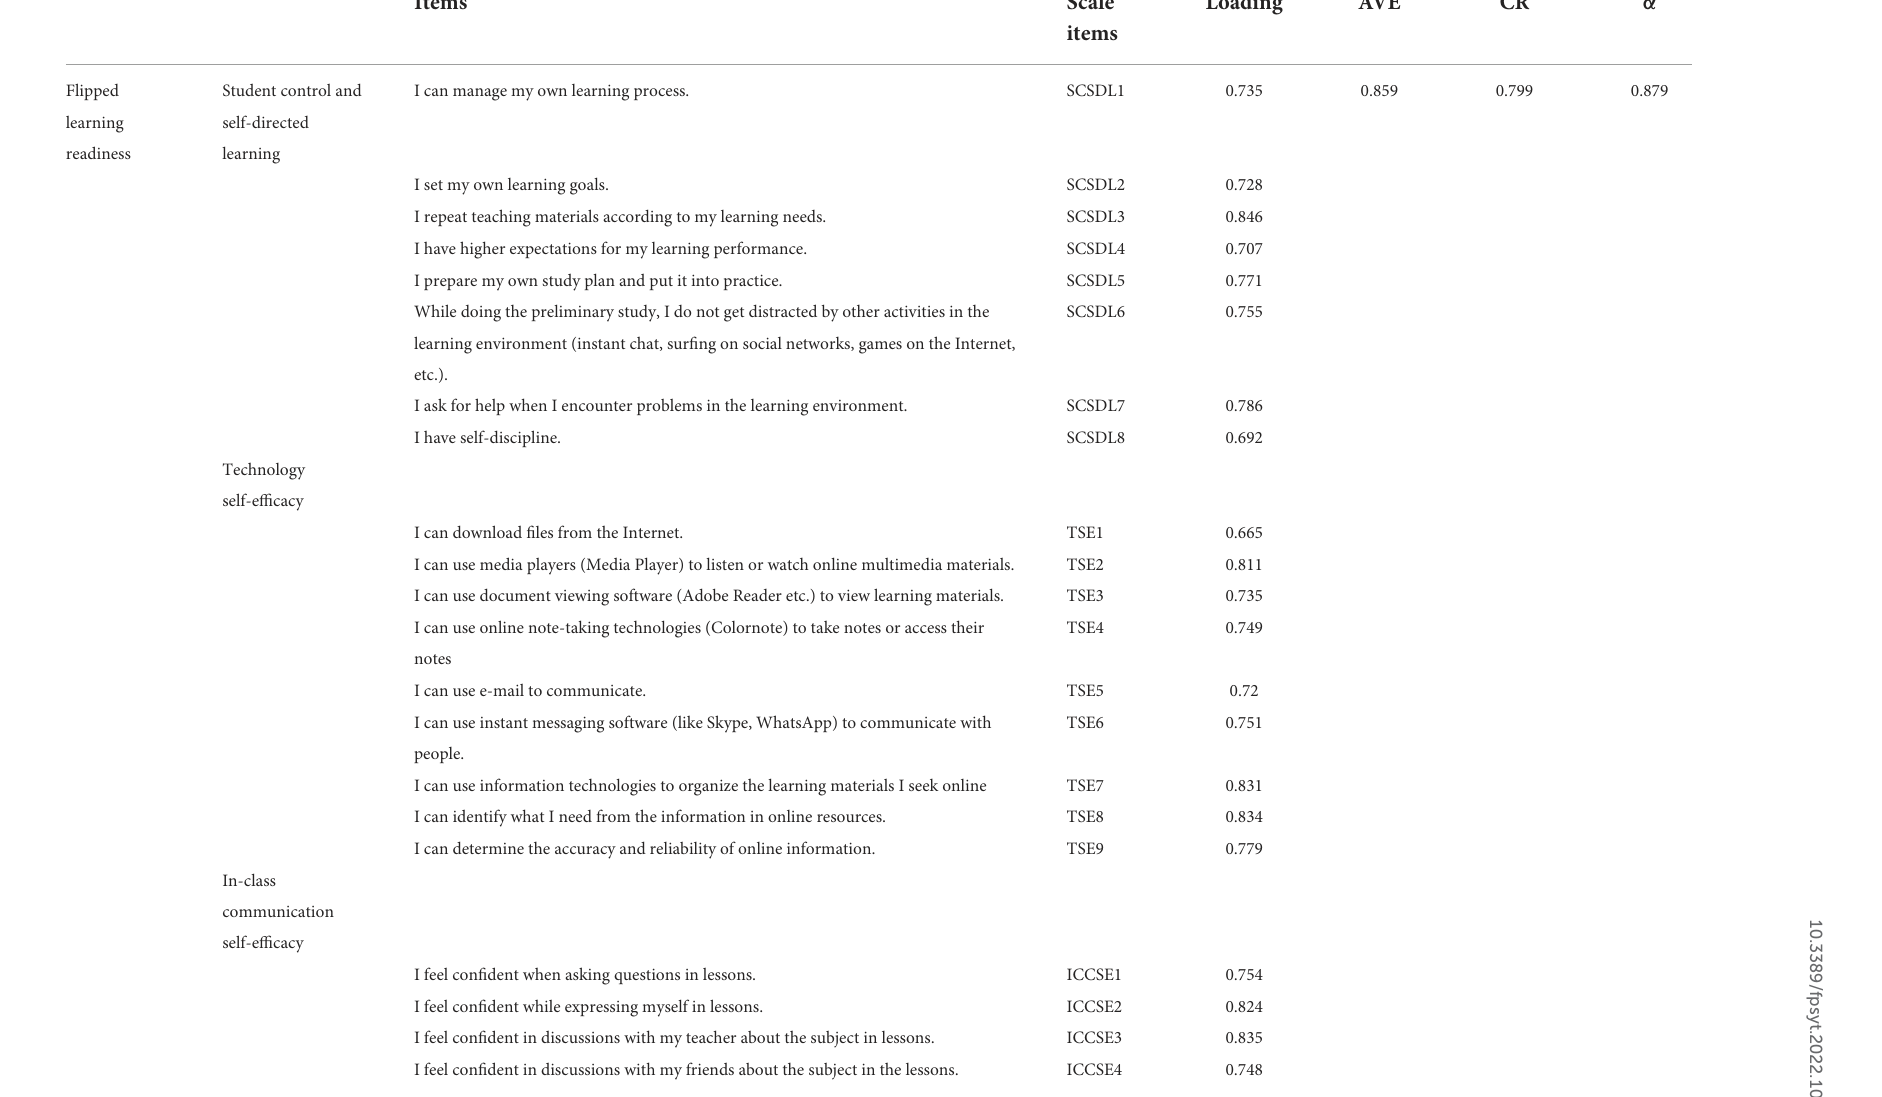
TABLE 2 Convergent validity, reliability and factor loadings. Items Scale